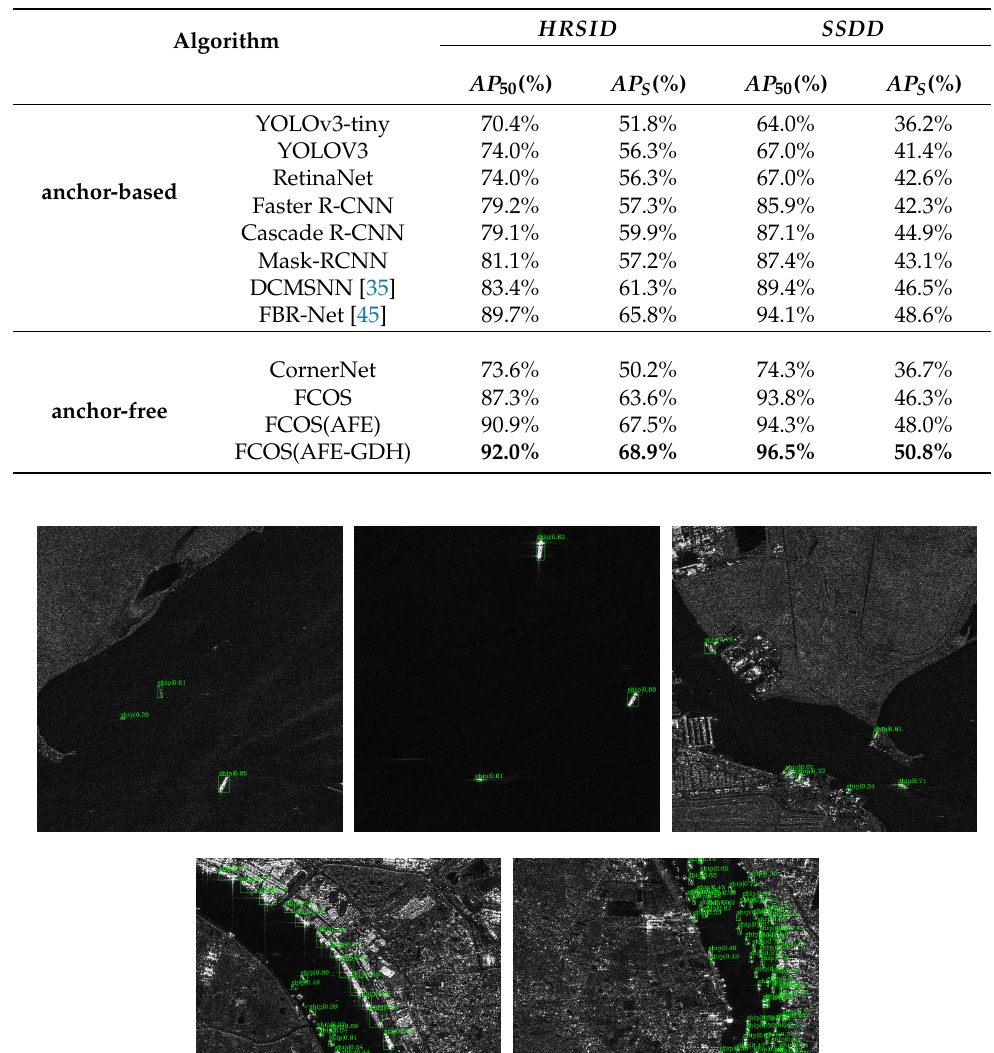
Table 12. Experimental results of the overall detection framework on HRSID and SSDD.